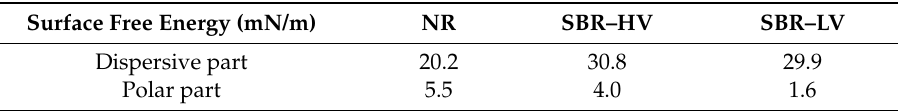
Table 4. Surface free energy of the raw